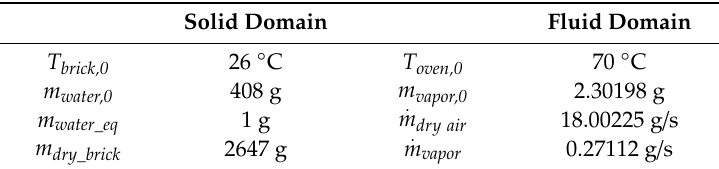
Table 2. Data used in the drying